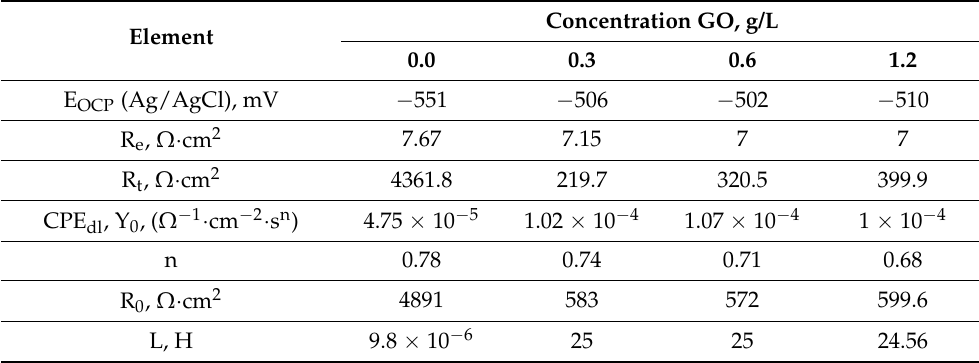
Table 8. The values of the elements for coated corrosion scheme for an acid solution.